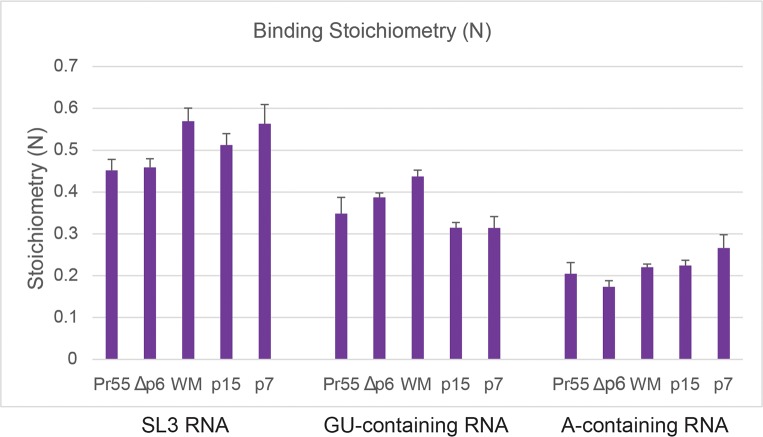
Stoichiometry of binding indicates higher number of Gag binds to A-containing RNA over GU-containing RNA and SL3.Calculated binding stoichiometry (N) from ITC binding curves fitted to a one-site interaction model plotted for replicate Gag protein interactions with SL3 RNA, GU-containing RNA (4’x 5’-GAUGG-3’) and A-containing RNA (4x 5’-GAGAA-3’) (n = 3). The binding stoichiometry (N) refers to RNA:Gag ratio.